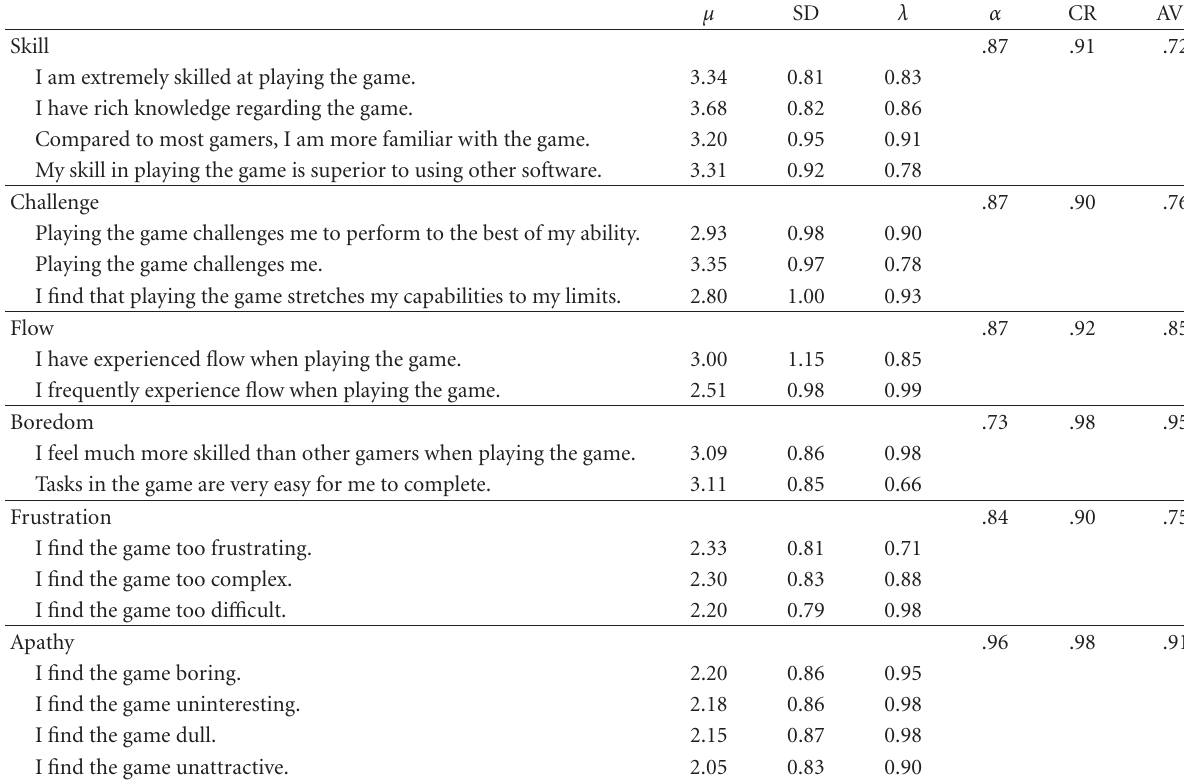
Table 1: Summary of confirmatory factor analysis.